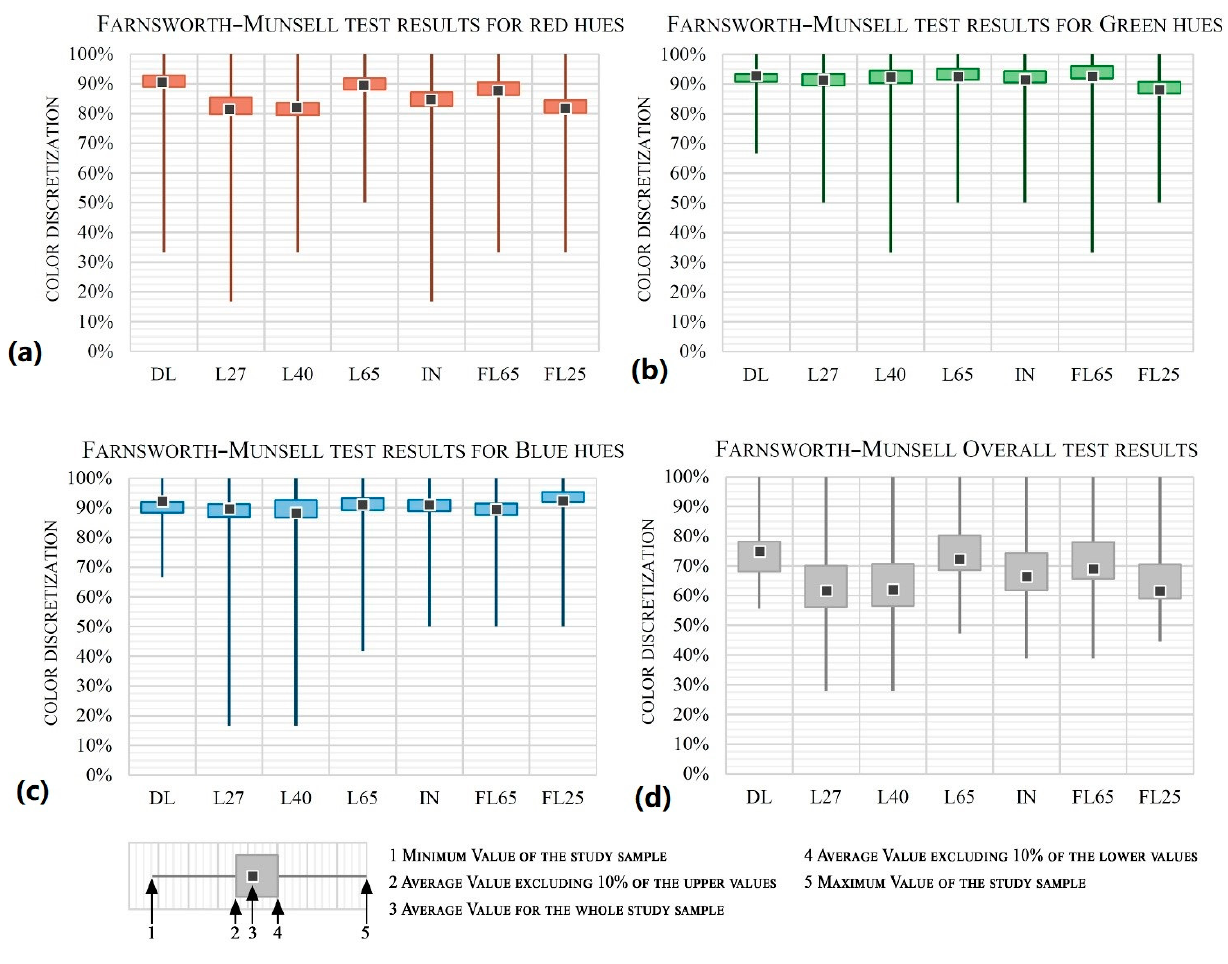
Figure 9. Quantification of the FM-100 trial, showing minimum, maximum and average values as well as averages excluding 10% upper and lower of the study sample. From left to right and above to below. ( a ) Upper left: Red hues. ( b ) Upper right: Green hues. ( c ) Lower left: Blue hues. ( d ) Lower right: Overall results.